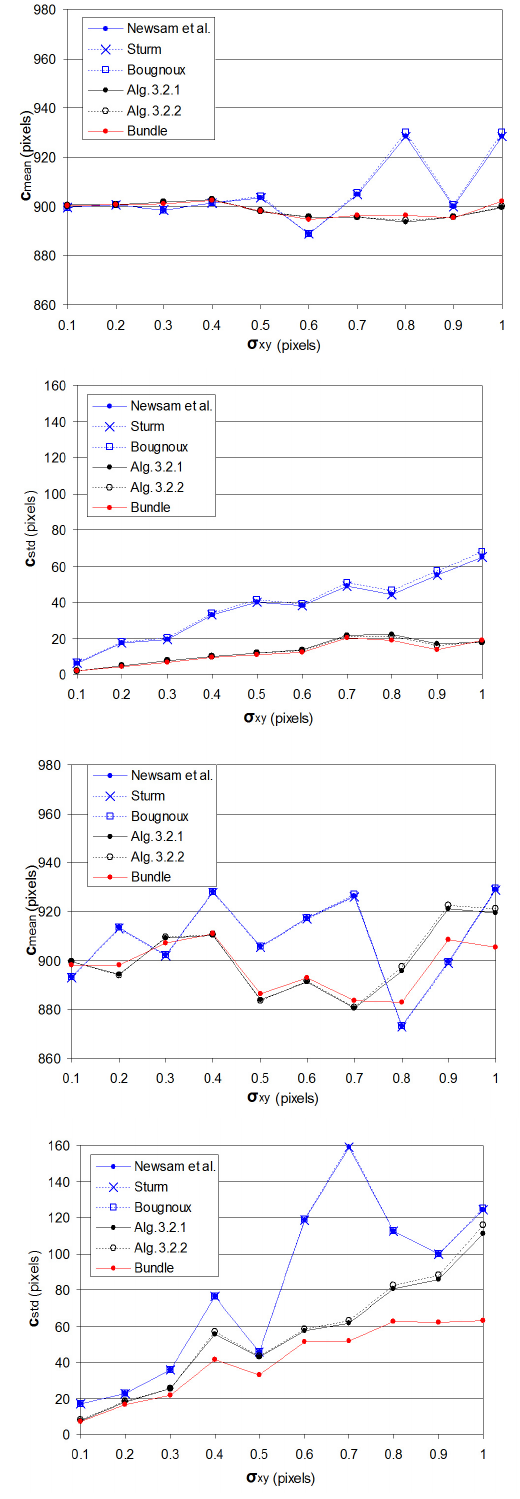
Figure 7. Comparison of different algorithms for the computation of a common camera constant value from two simulated configurations (the same as in Figure 6) at different noise levels. Mean values and standard deviations are given from 20 solutions per noise